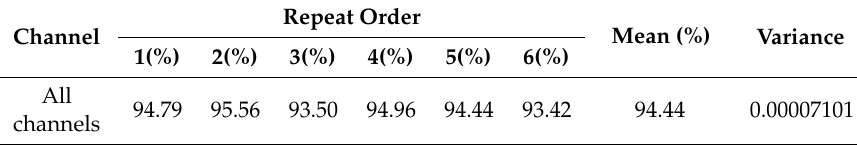
Table 2. Fault diagnosis results using LS-SVM model with all channels data.